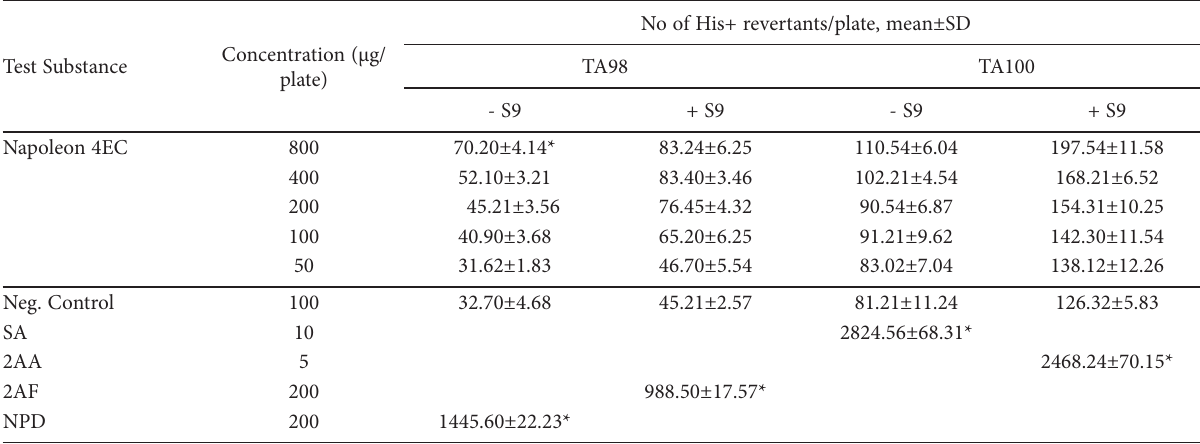
Table 1. The mutagenicity assay results of Napoleon 4EC for S. tyhimurium TA98 and TA100 strains.